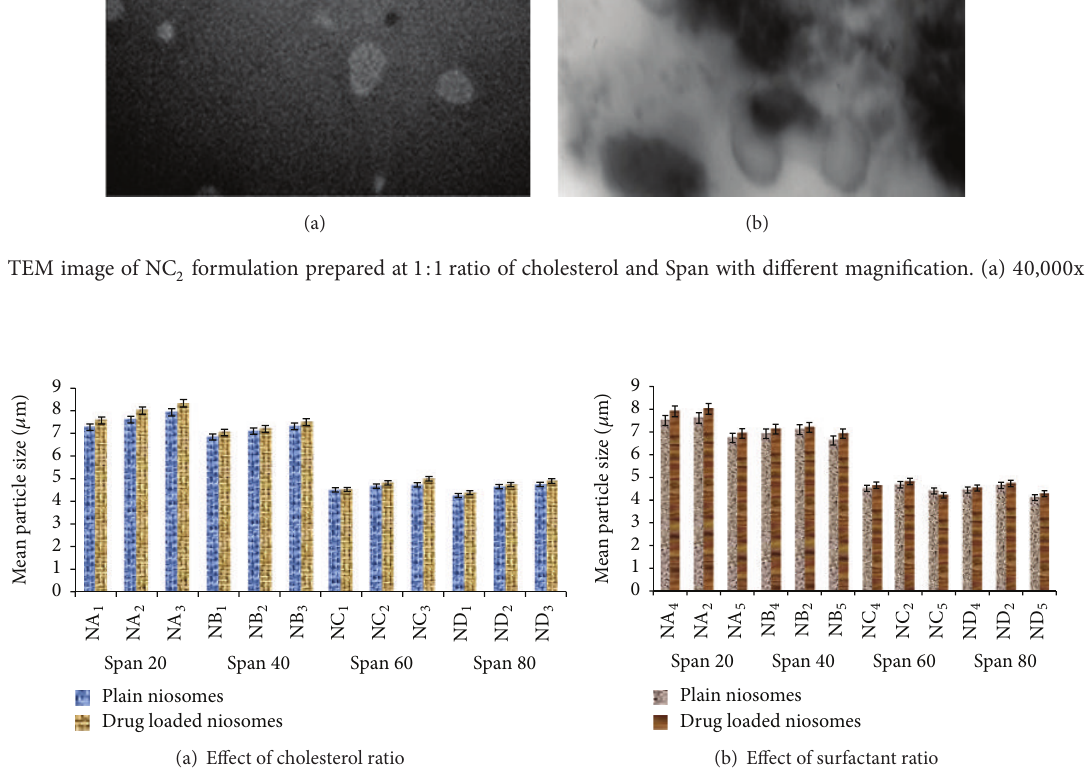
Figure 3: Effect of cholesterol and surfactant ratio on particle size of niosomes containing different series of